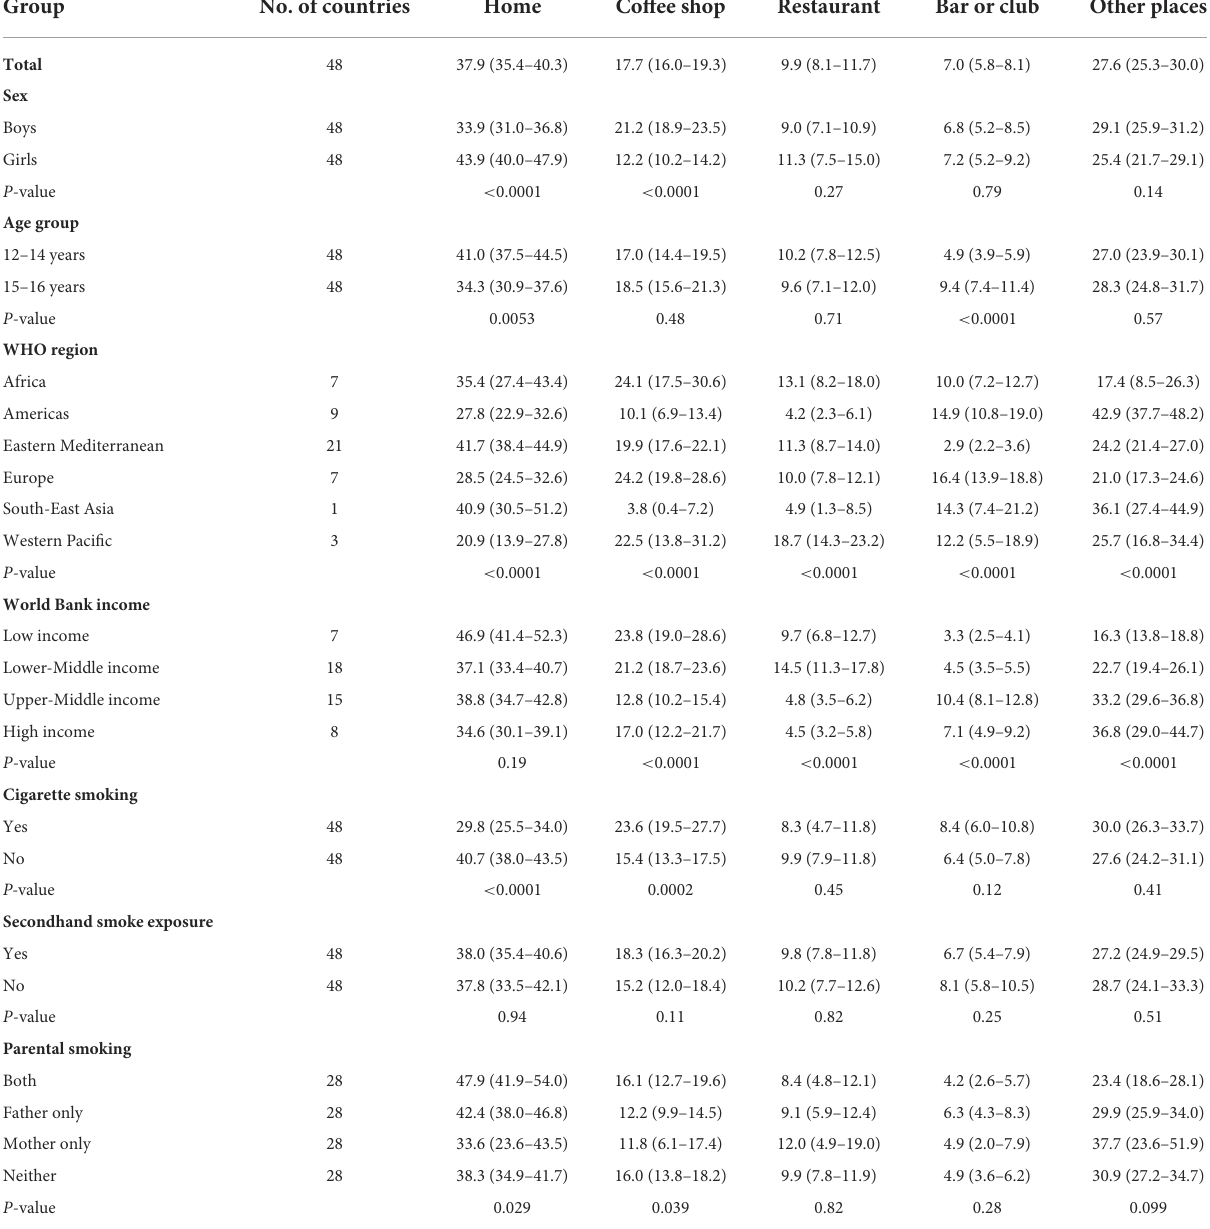
TABLE 2 Proportions of the last place of waterpipe smoking during the past 30 days among adolescent waterpipe users by sex, age group, WHO region, World Bank income category, cigarette use, secondhand smoke exposure, and parental smoking,